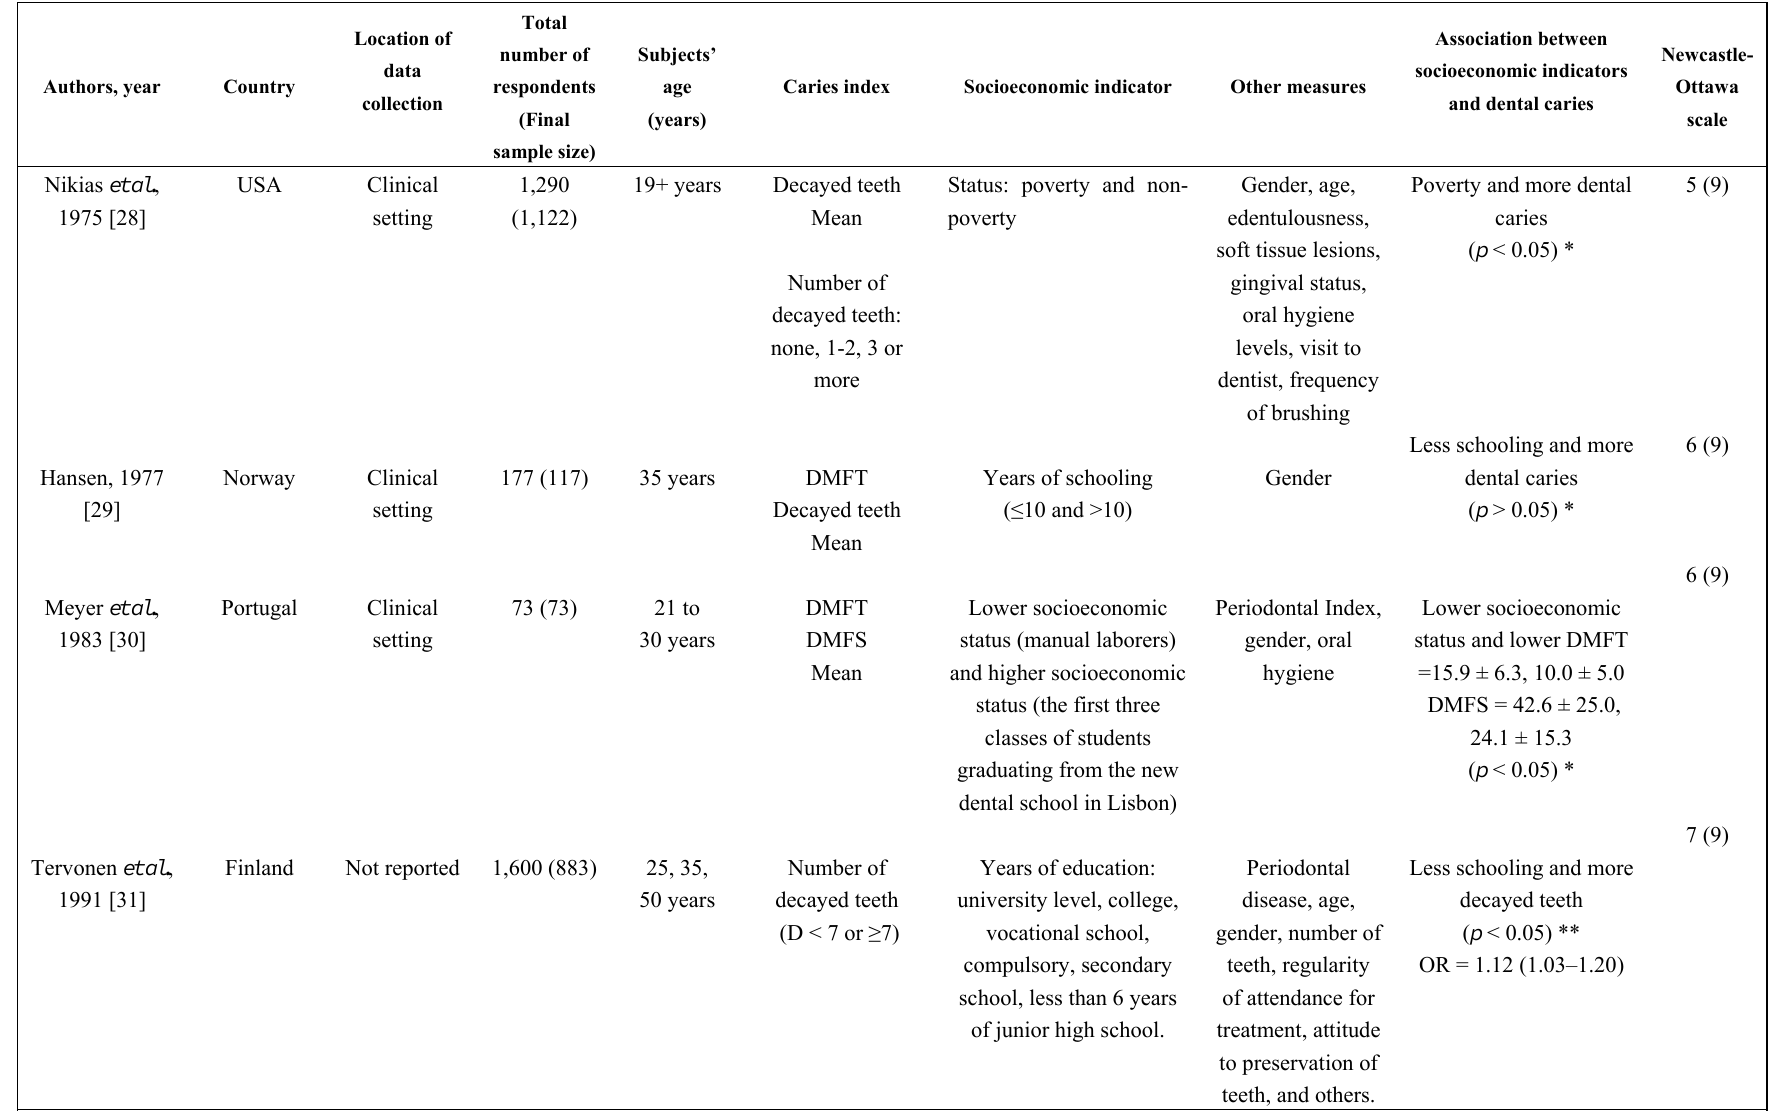
Table 1. Study characteristics and results reported from cross-sectional